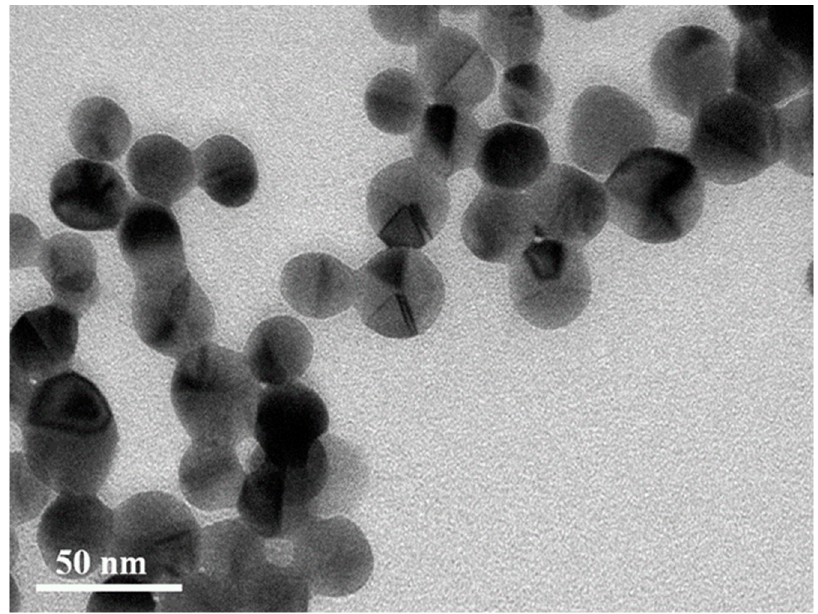
Figure 6. TEM image of the snipped D-AgNPs. The snipped D-AgNPs have an LSPR band that peaked at ca. 448 nm, corresponding to spectrum d of Figure 5.